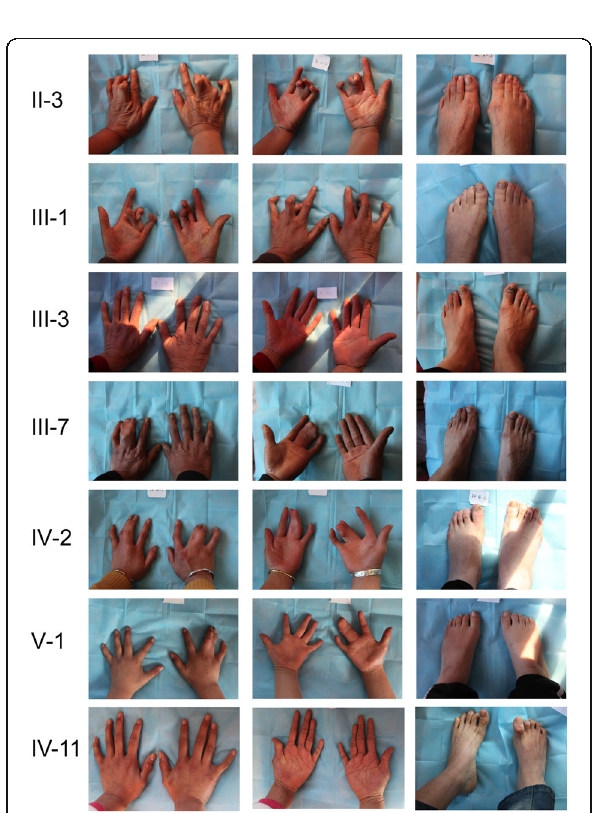
Fig. 2 Photographs of the affected members of the family showing hand and foot deformities